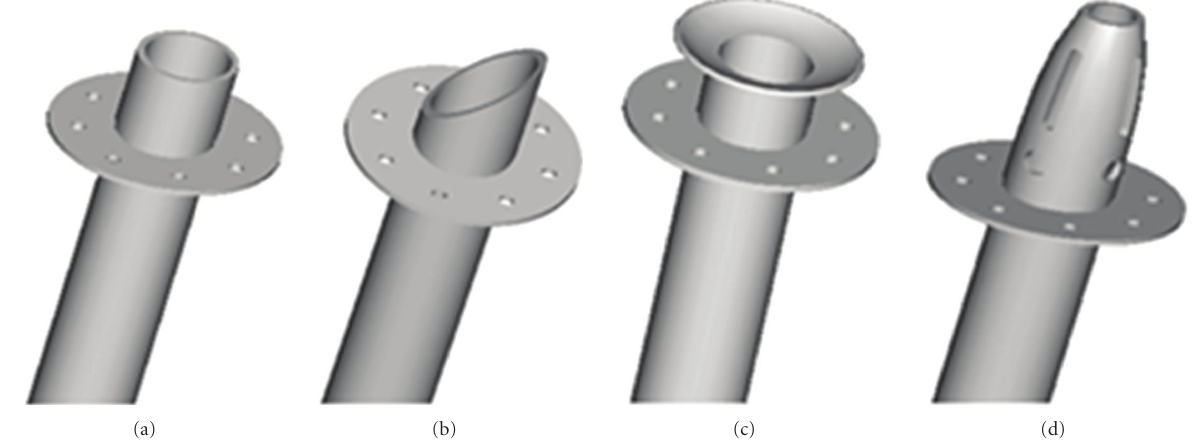
Figure 1: 3D model of inflow cannula tip: (a) blunt, (b) beveled, (c) trumpet, and (d) caged.